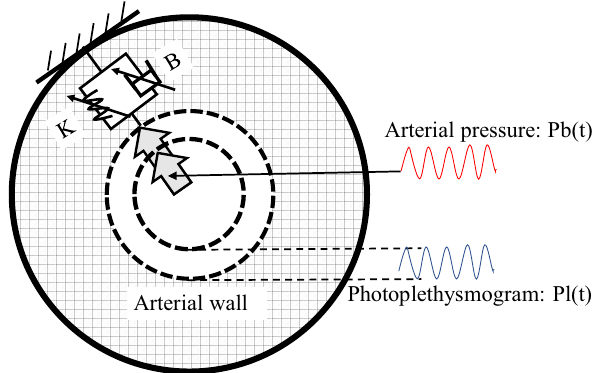
Figure 1. Schematic diagram of the mechanical impedance model. The model used in this study consists of a parallel arrangement of springs and dampers across the diameter of the arterial wall. When a force (blood pressure) is applied across the diameter of the artery, the arterial wall is dampened by springs and dampers that represent the rigidity and viscosity of the arterial wall itself. The behavior of the arterial wall after damping is observed as a change in the photoplethysmogram